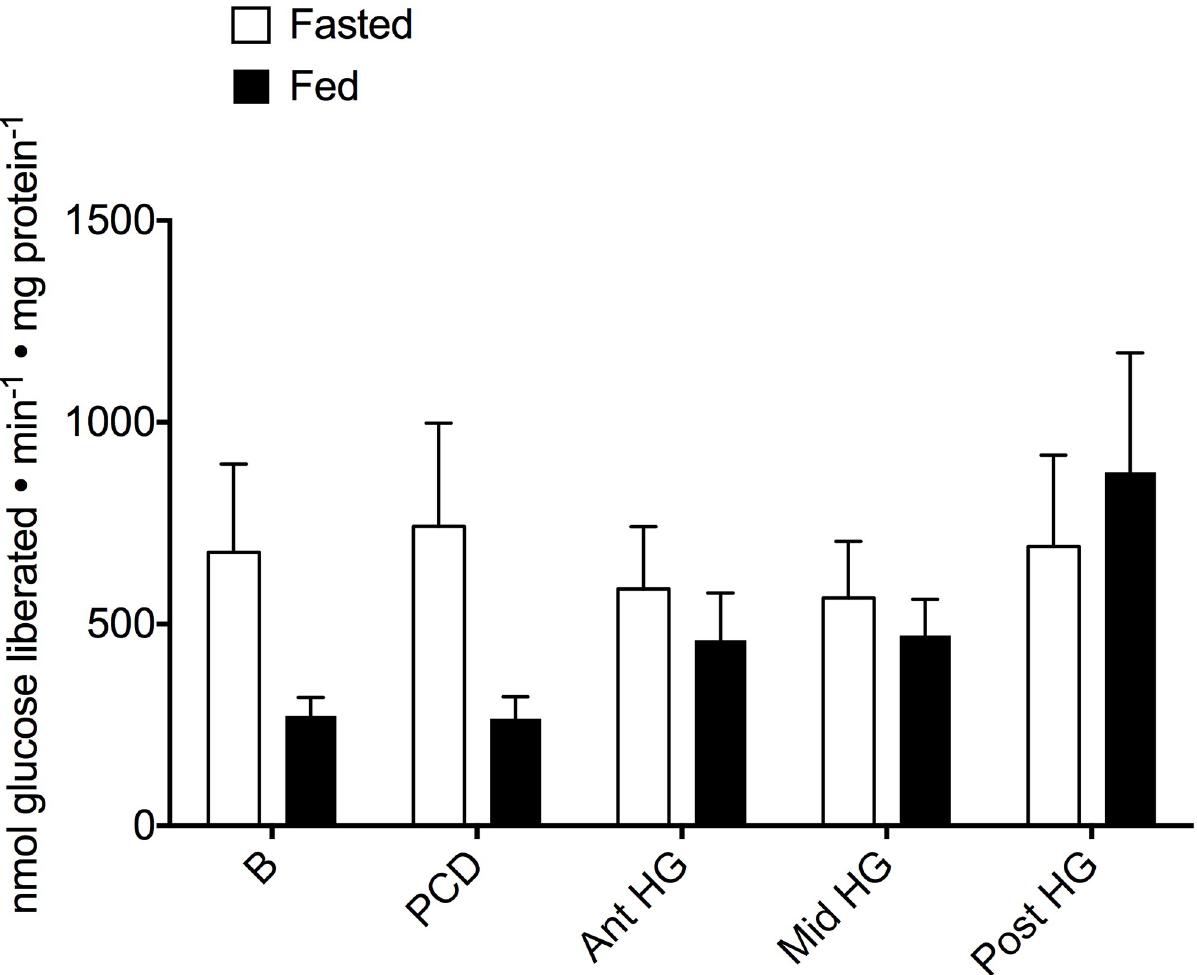
Fig 2. Maltase activity (nmol glucose liberated min -1 mg protein -1 ) does not change with feeding or location in the Pacific hagfish alimentary canal. Activity was measured in both fasted (white bars) and fed (black bars) hagfish in five locations down the alimentary canal (B—buccal cavity, PCD —pharyngocutaneous duct, Ant HG—anterior hindgut, Mid HG—mid hindgut, Post HG—posterior hindgut). Bars represent means + s.e.m. of 4–7 preparations. A 2-way ANOVA of the entire tract determined there were no significant effects of feeding or location ( α = 0.05).